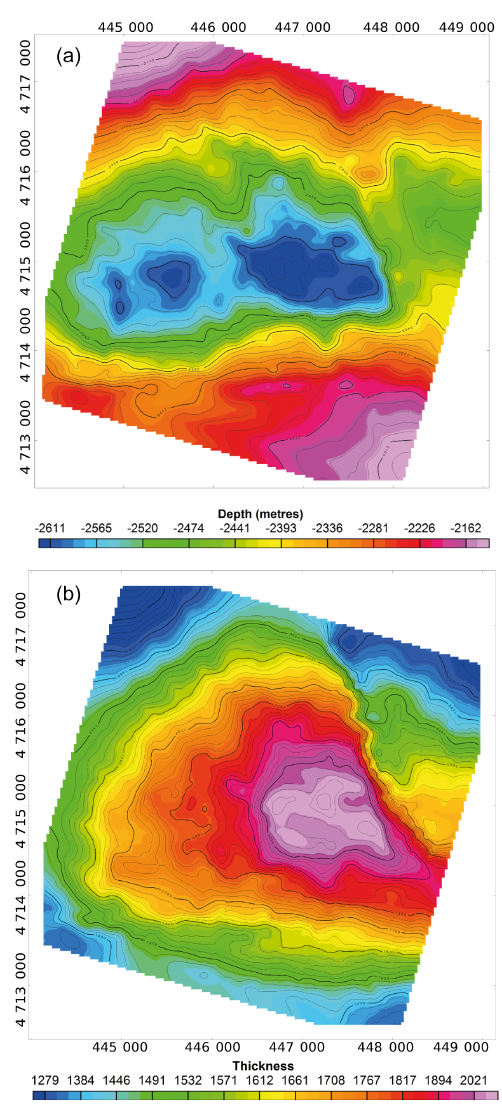
Figure 8. (a) Basement topography derived from the inversion of the residual gravity data shown in Fig. 7d, and (b) thickness map of the Triassic Keuper evaporites after comparing the basement topog- raphy and the bottom of the sedimentary